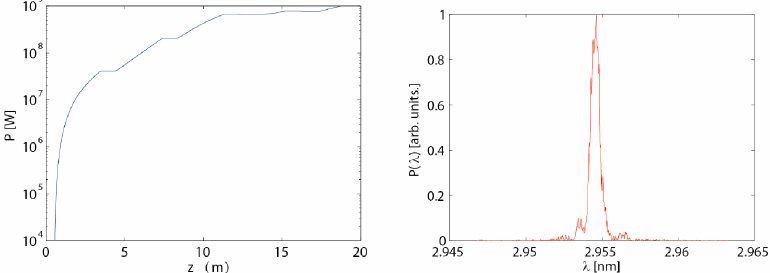
Figure 15. Simulated FEL performance of the seeded line at 3 nm output: gain curve and the output spectrum. Appl. Sci. 2017 , 7 , 607